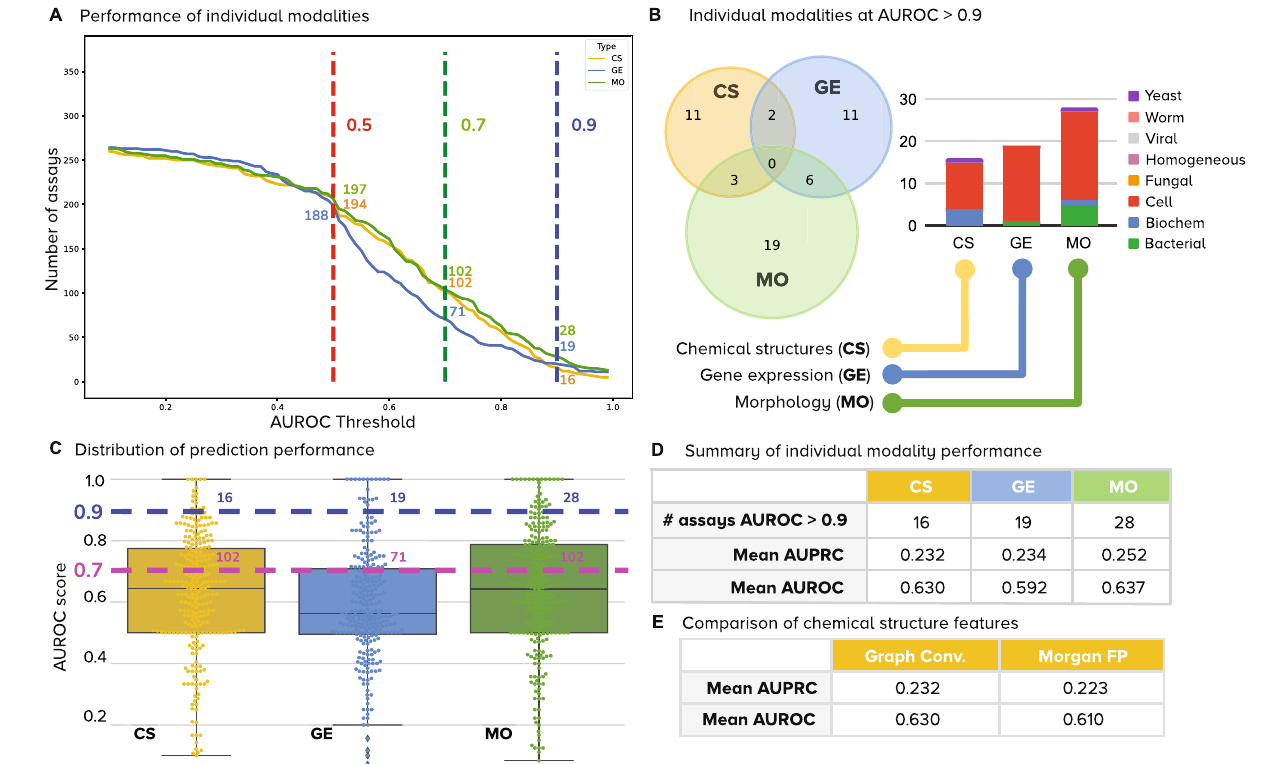
Fig.2|Numberofassaysthatcanbeaccuratelypredictedusingsinglepro fi ling modalities. All reported numbers are the median result of the fi ve-fold cross- validation experiments run in the dataset. A Performance of individual modalities measured as the number of assays (vertical axis) predicted with AUROC above a certain threshold (horizontal axis). With higher AUROC thresholds, the number of assays that can be predicted decreases for all pro fi ling modalities. We de fi ne accurateassaysasthosewithAUROCgreaterthan0.9(dashedverticallineinblue). B The Venn diagrams on the right show the number of accurate assays (median AUROC>0.9) that are in common or unique to each pro fi ling modality. The bar plot shows the distribution of assay types correctly predicted by single pro fi ling